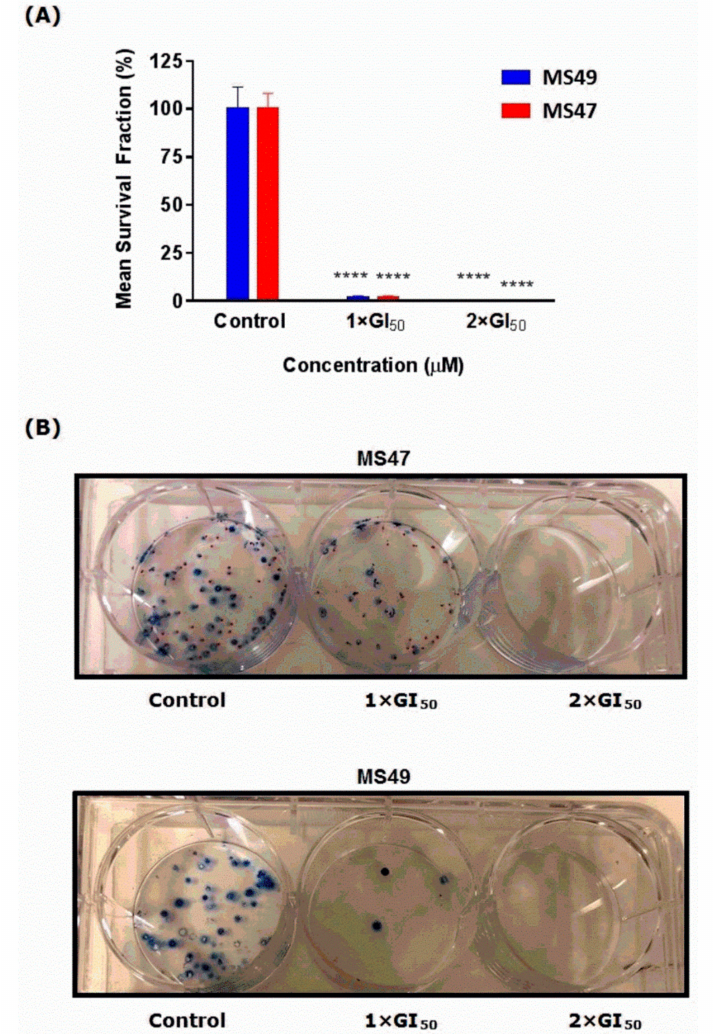
Figure 5. Effects of MS47 and MS49 on colony formation. ( A ) Mean ± SEM survival fraction (%) of the treated cells as a percentage of the control population for human melanoma MDA-MB-435 cells. MS47 and MS49 caused a significant inhibition in the colony formation (**** p < 0.0001, n = 2 for each of the three independent experiments). ( B ) Representative photographs show the effects of MS47 and MS49 on melanoma MDA-MB-435 colony formation in the control, 1 × GI 50 and 2 × GI 50